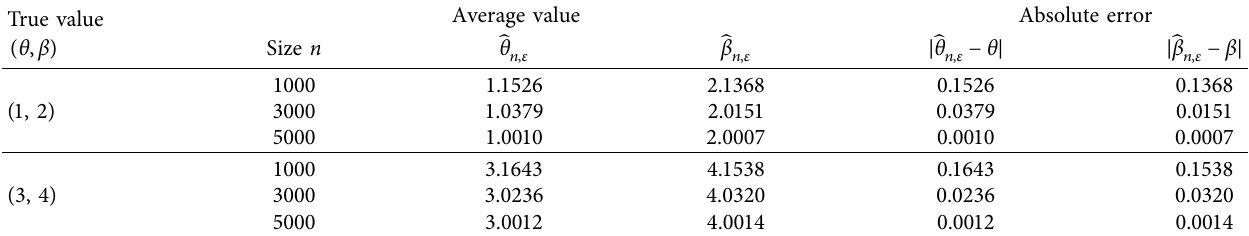
Table 1: Least squares estimator simulation results of θ and β .